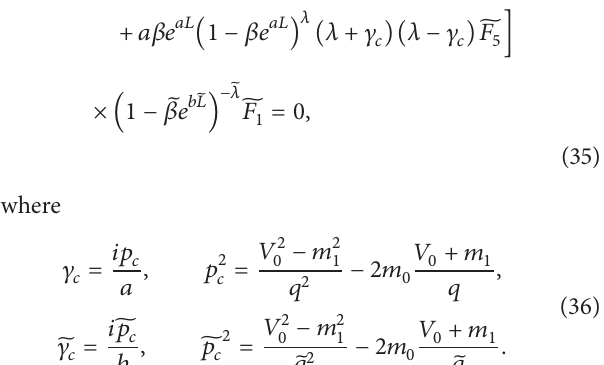
Figure 4: The effect of position dependent mass for the Woods-Saxon potential on transmission coefficient. (a) shows 𝑉 0 = 1.2 , 𝐿 = 10 , ̃𝐿 = 10 , 𝑎 = 3 , 𝑏 = 3 , 𝑝 = 1 , ̃𝑝 = 1 , 𝑞 = 1 , ̃𝑞 = 1 , and 𝑚 0 = 0.4 . (b) shows 𝐸 = 0.8 , 𝐿 = 10 , = 0.4 𝑚 0